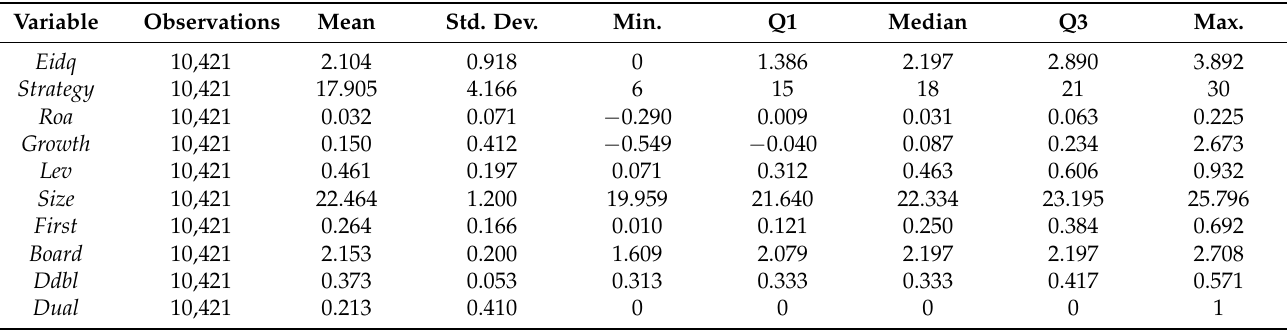
Table 4. Descriptive statistics of main variables.